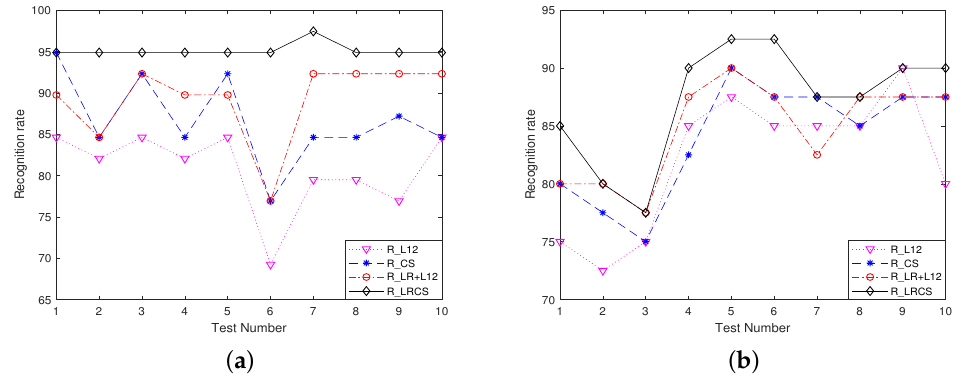
Figure 8. Error terms of two kinds of gross corruptions: ( a ) Random sparse corruptions. ( b ) image-specific